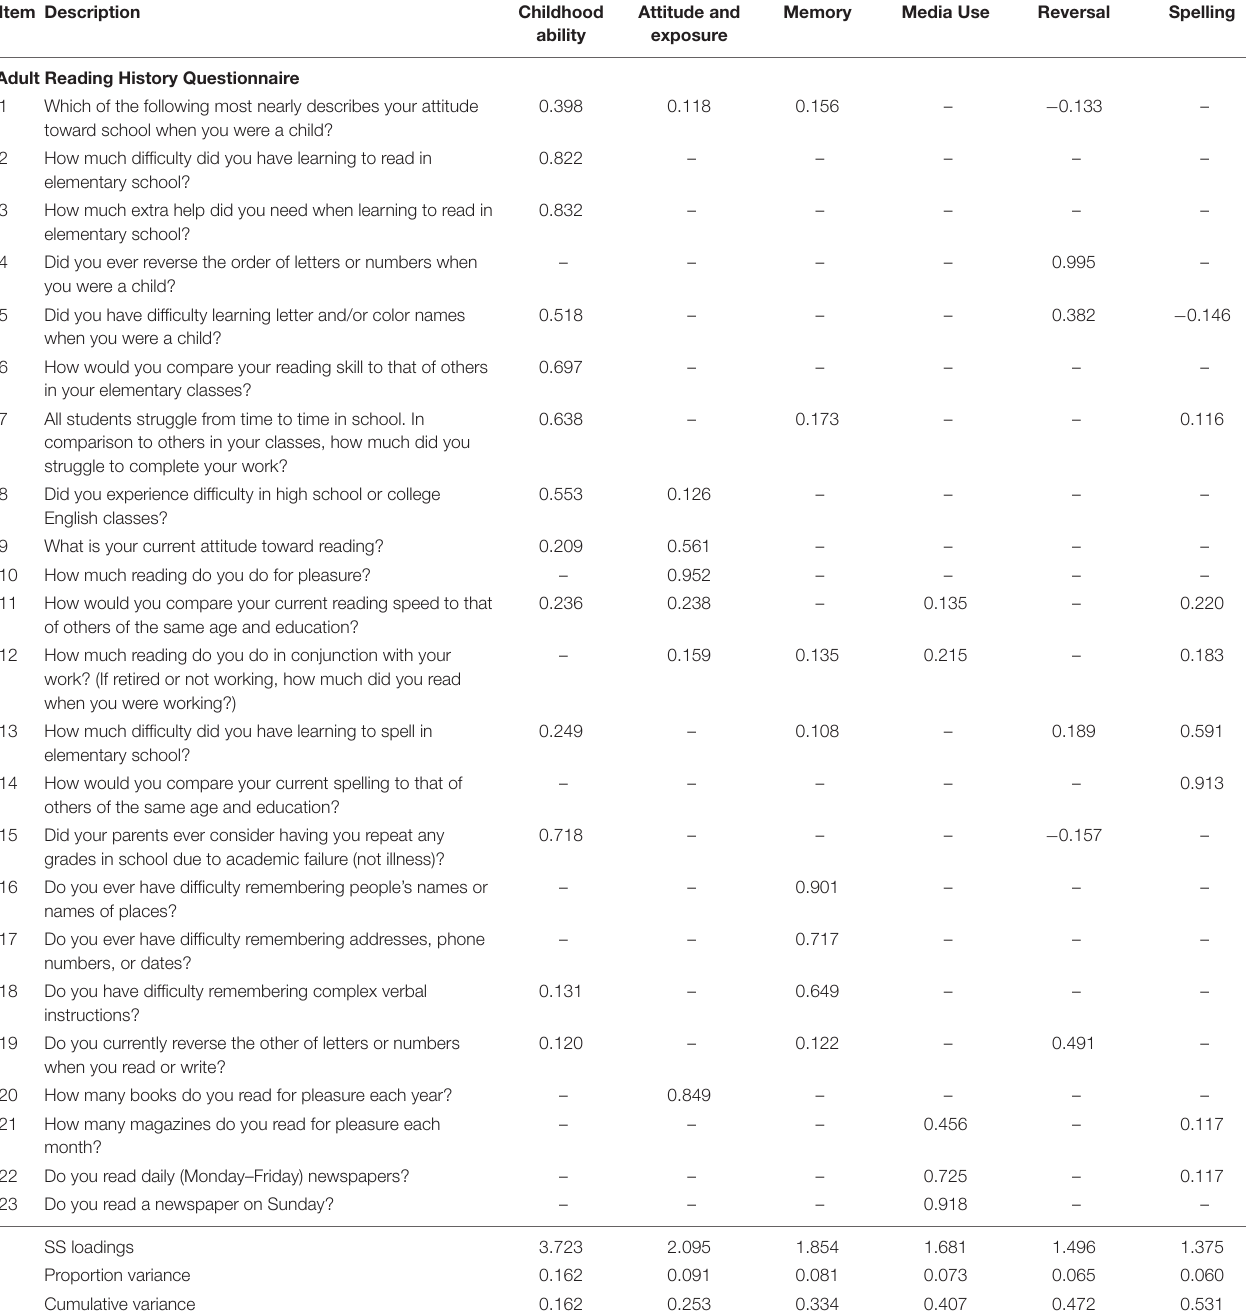
TABLE 3 | Factor loadings for individual items in the structure revealed from the ARHQ, wherein the solution was reported with ( Factor 1 ) Childhood Ability, ( Factor 2 ) Attitude and Exposure, ( Factor 3 ) Memory, ( Factor 4 ) Media Use, ( Factor 5 ) Reversal, and ( Factor 6 ) Spelling. Item